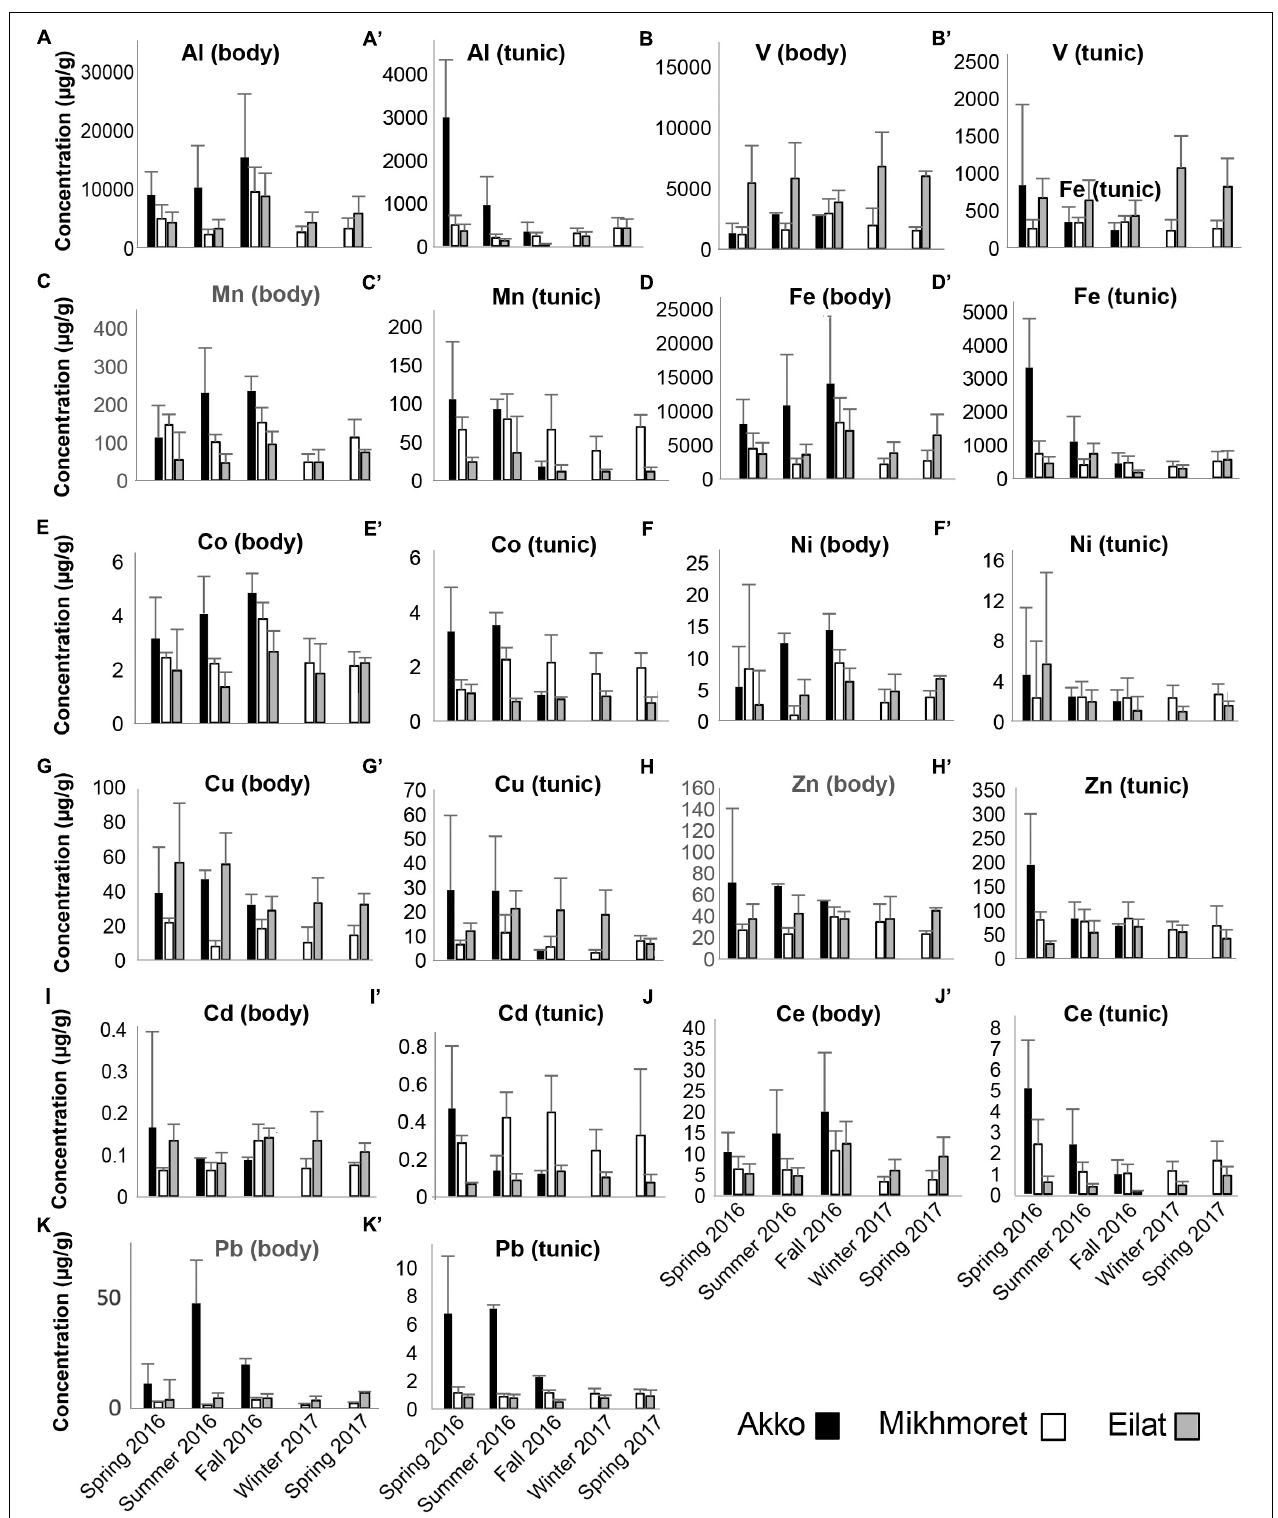
FIGURE 5 | Metal concentrations ( µ g/g) in the bodies (A–K) and tunics (A’–K’) of P. nigra, measured in the specimens sampled from Akko, Mikhmoret, and Eilat, during the different seasons of the study (Spring 2016–Spring 2017). Mean ± SD is presented for all the metals, except for Al, Fe, and Ce, for which ± SE is presented ( n =